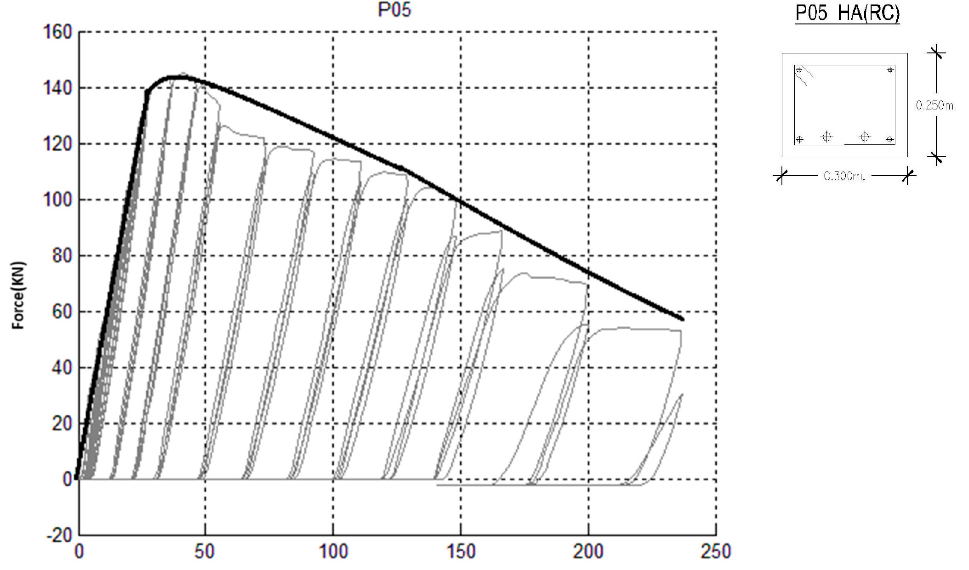
Figure 28. Force–displacement graph of experimental results of P05.